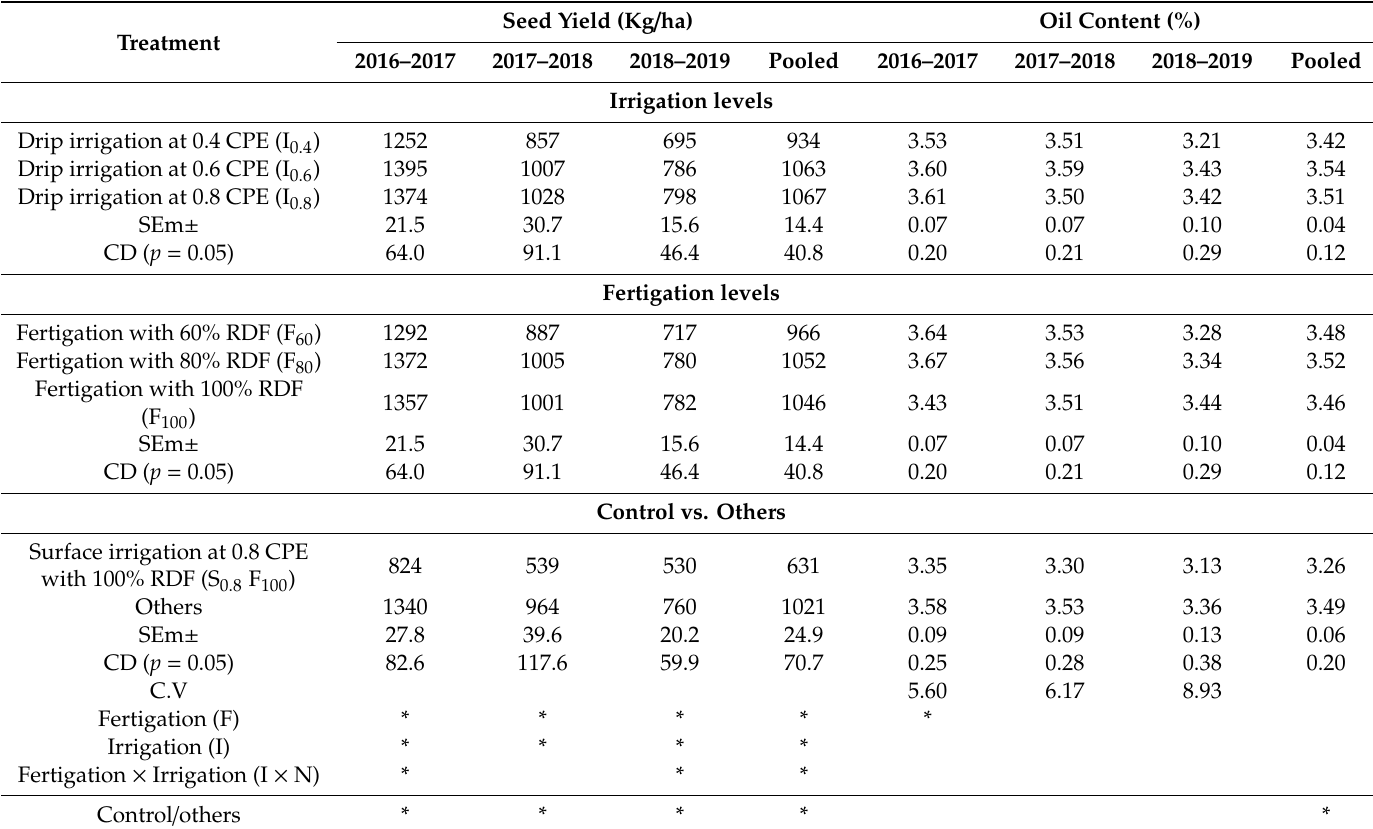
Table 2. E ff ect of drip irrigation and fertigation levels on yield and oil content of cumin (pooled data of three years).